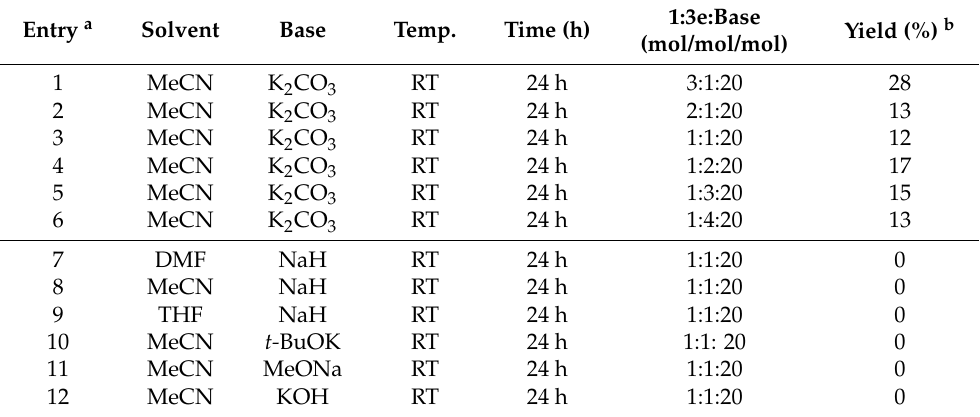
Scheme 1. Model reaction for optimization of conditions. Table 1. Optimization of reaction conditions for N -alkylation of 5,6-dibromobenzimidazole 1 with 2,4-dichlorophenacyl chloride 3e .